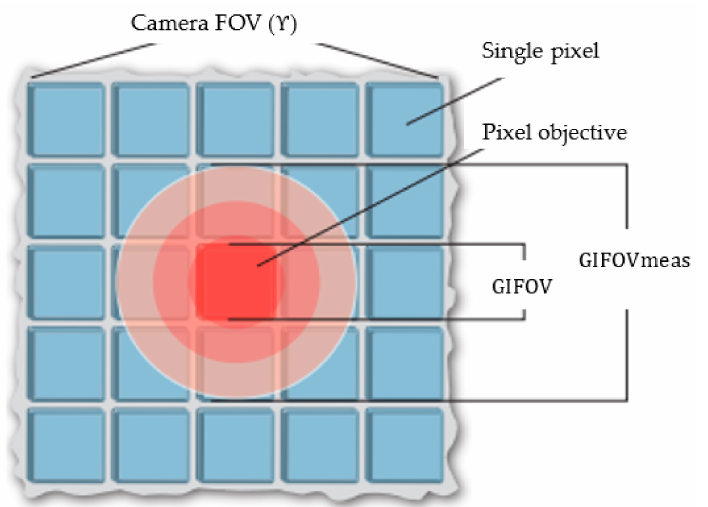
Figure 6. GIFOVmeas